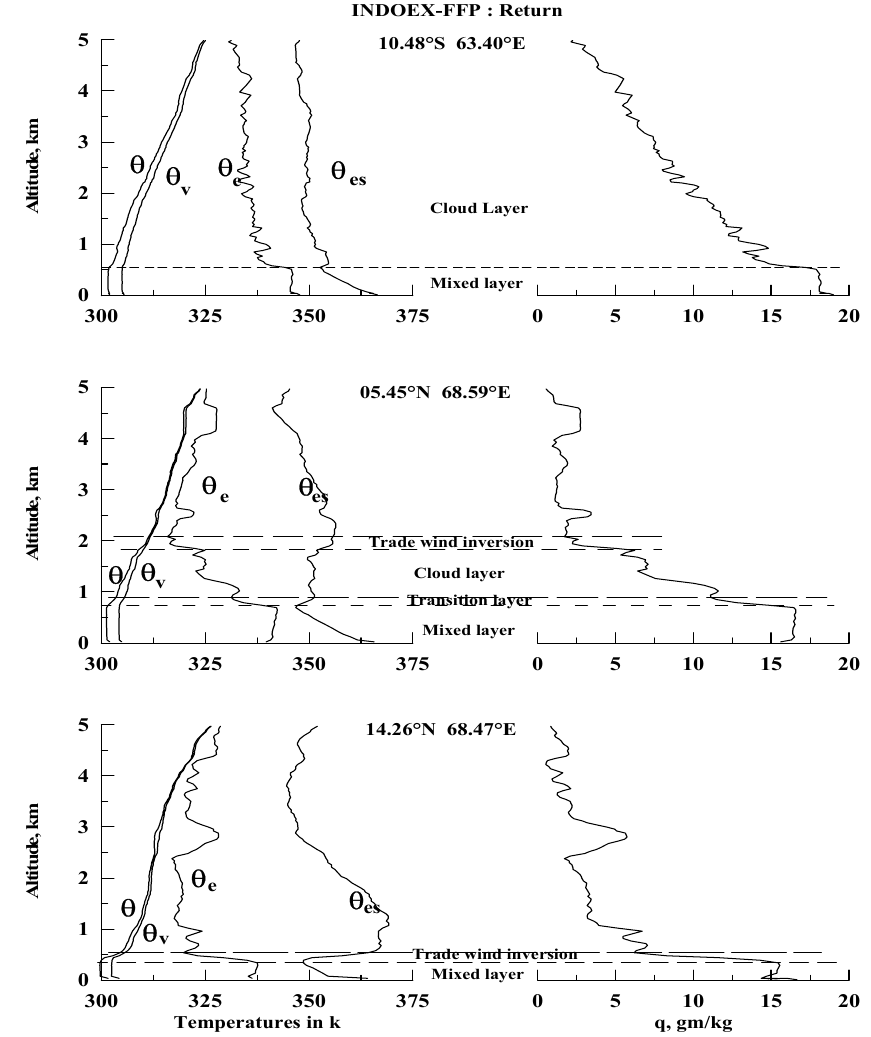
Figure 7 Fig. 7. Altitude profiles of potential temperature ( θ ), virtual potential temperature ( θ v ), equivalent potential temperature ( θ e ),